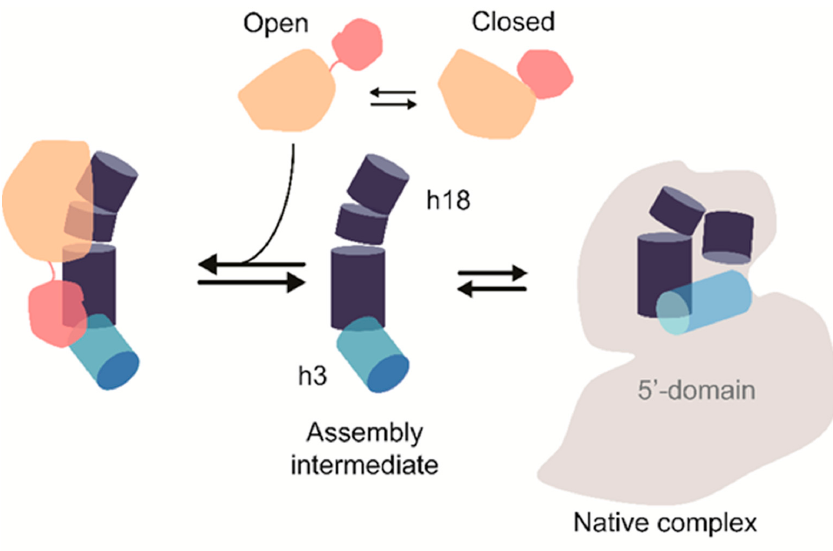
Figure 6. The current working model for RsuA binding is shown.